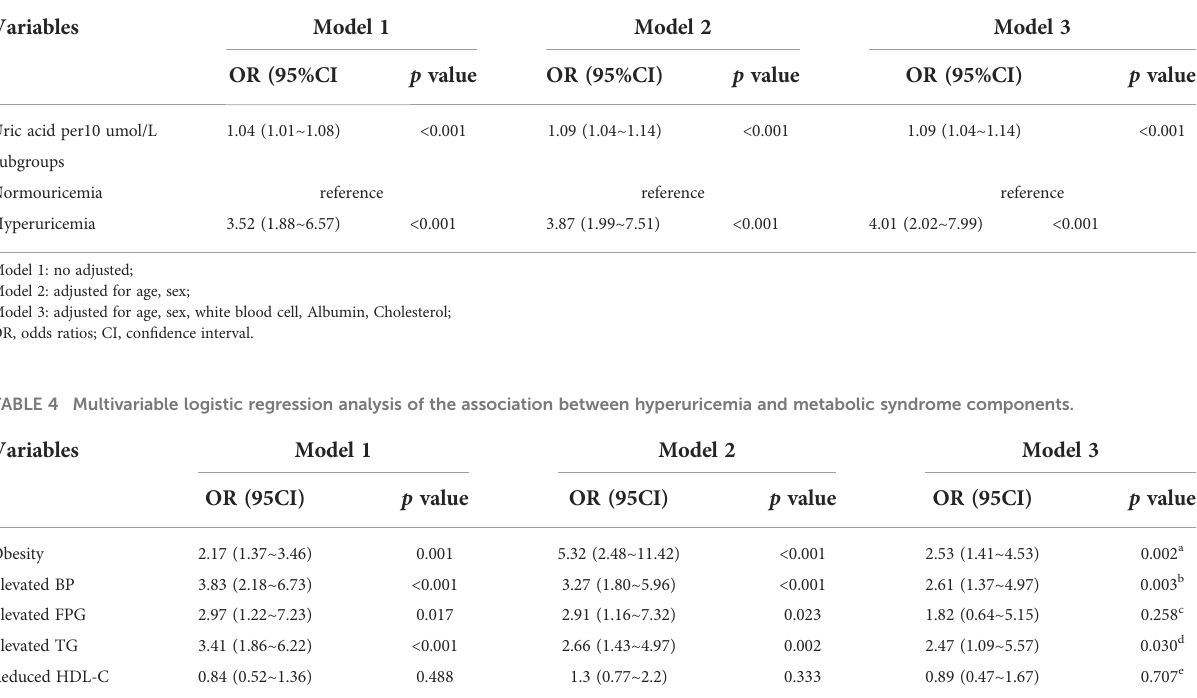
TABLE 3 Multivariable logistic regression analysis of the association between serum uric acid and metabolic